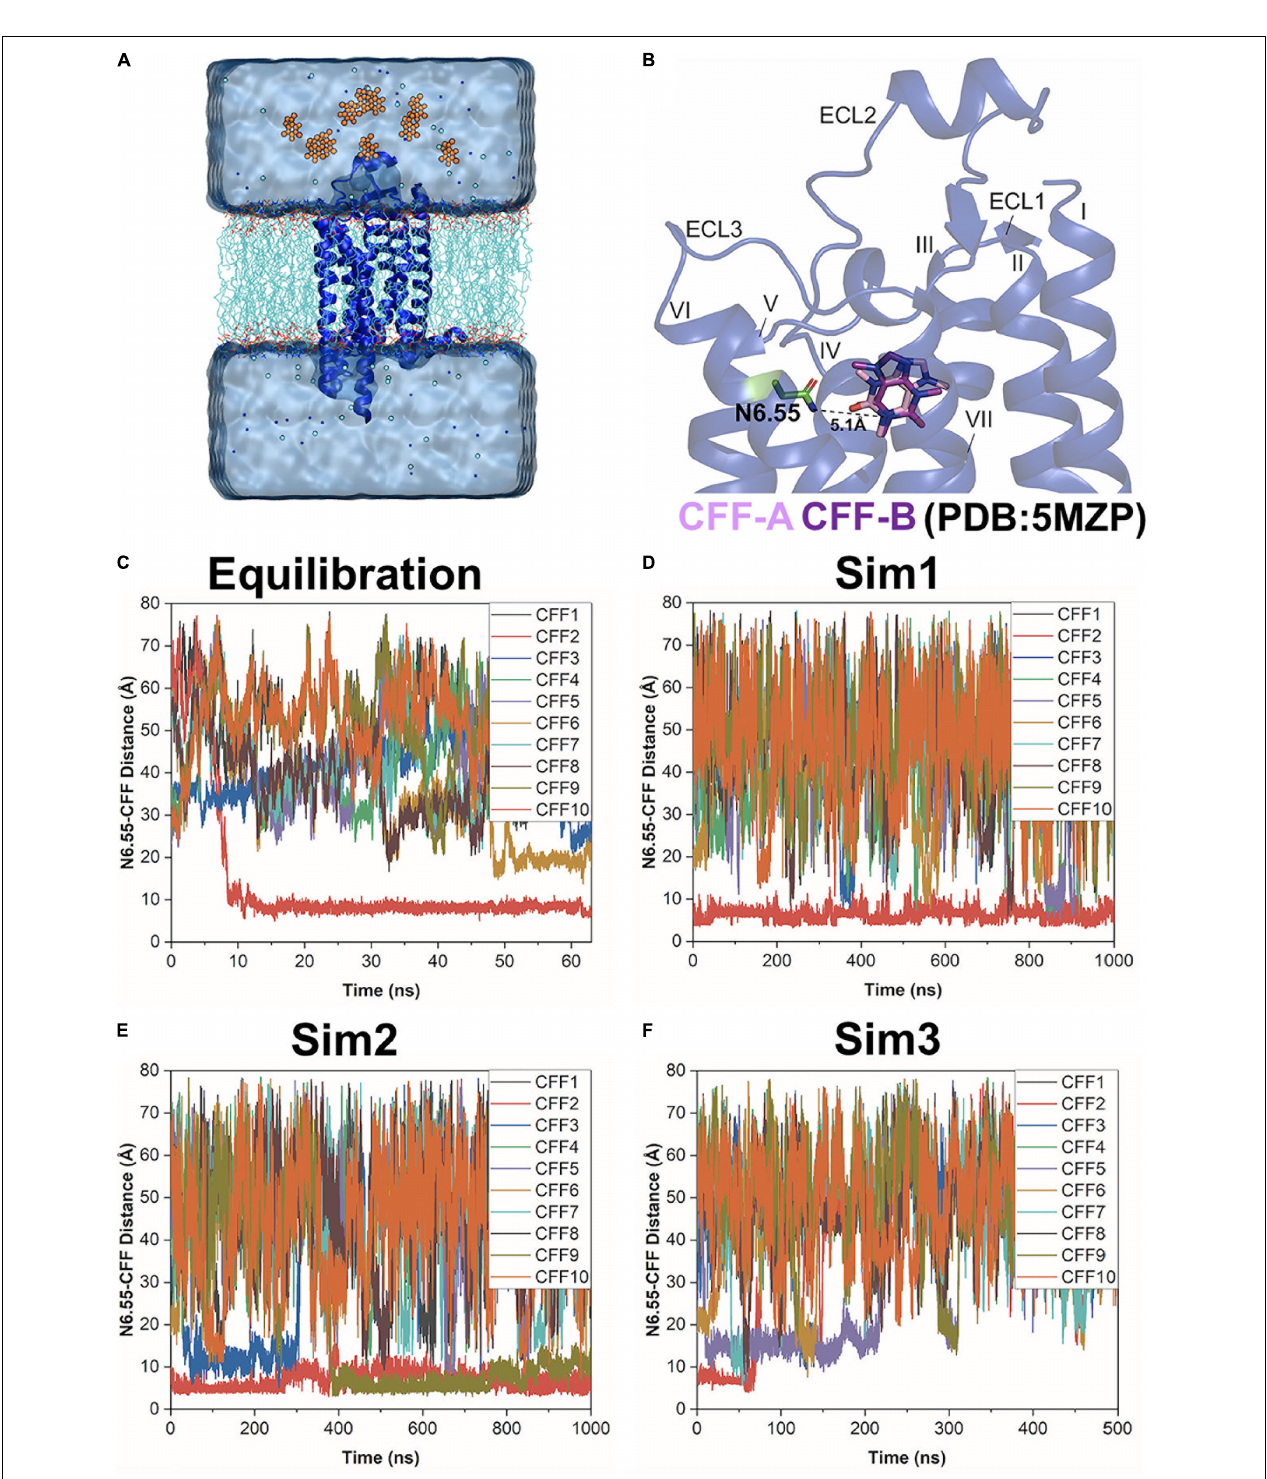
FIGURE 1 | Gaussian-accelerated molecular dynamics (GaMD) simulations successfully captured both binding and dissociation of caffeine (CFF) in the A 2A AR. (A) Computational model used for simulations of the A 2A AR (blue ribbons) with 10 CFF molecules (orange spheres) placed far away in the solvent. The receptor was inserted in a POPC lipid bilayer (cyan sticks) and solvated in an aqueous solution (cyan) of 0.15 M NaCl. (B) X-ray structure of CFF-bound A 2A AR (PDB: 5MZP). A hydrogen bond is formed between either O11 or O13 atom of CFF with the ND2 atom of the receptor residue N6.55 in two X-ray conformations of the ligand (CFF-A and CFF-B), in which the distance between the N1 atom that connects atoms O11 and O13 in CFF and the ND2 atom of residue N6.55 stays at 5.1 Å. The seven transmembrane (TM) helices I–VII and three extracellular loops (ECL) 1–3 are labeled in the A 2A AR. (C–F) Time courses of the N6.55:ND2–CFF:N1 distance calculated from 63 ns GaMD equilibration and three independent 500–1,000 ns GaMD simulations.